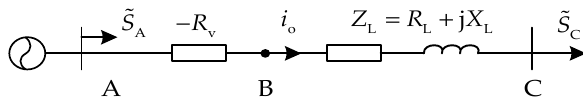
Figure 3. Equivalent circuit of virtual impedance method.